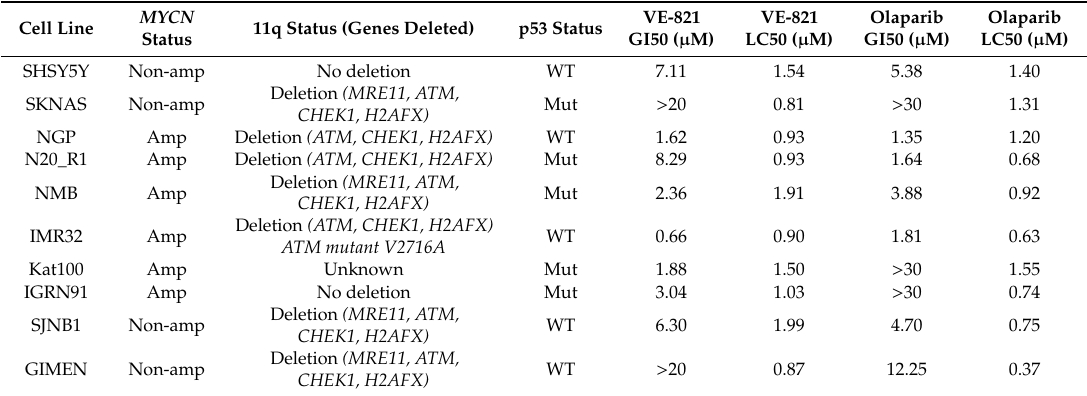
Table 2. Summary of VE-821 and olaparib single agent